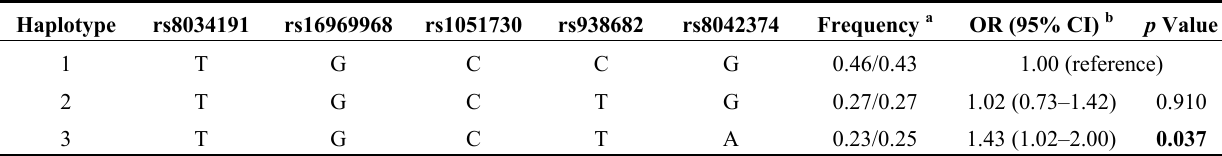
Table 3. Haplotype analyses of five SNPs in 15q25.1 with lung adenocarcinoma risk.